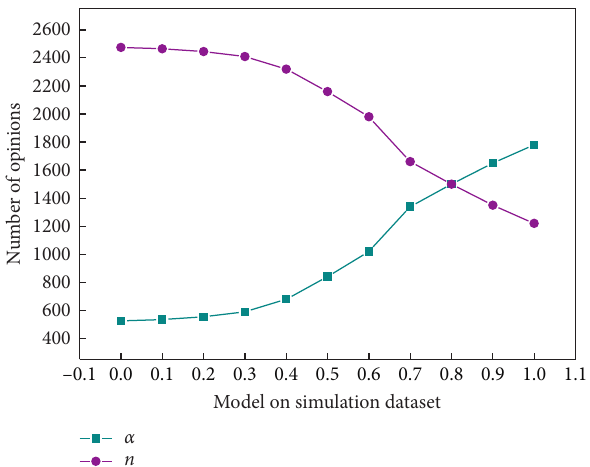
Figure 5: Average accuracy and recall for 7 courses from pair-rate regression.